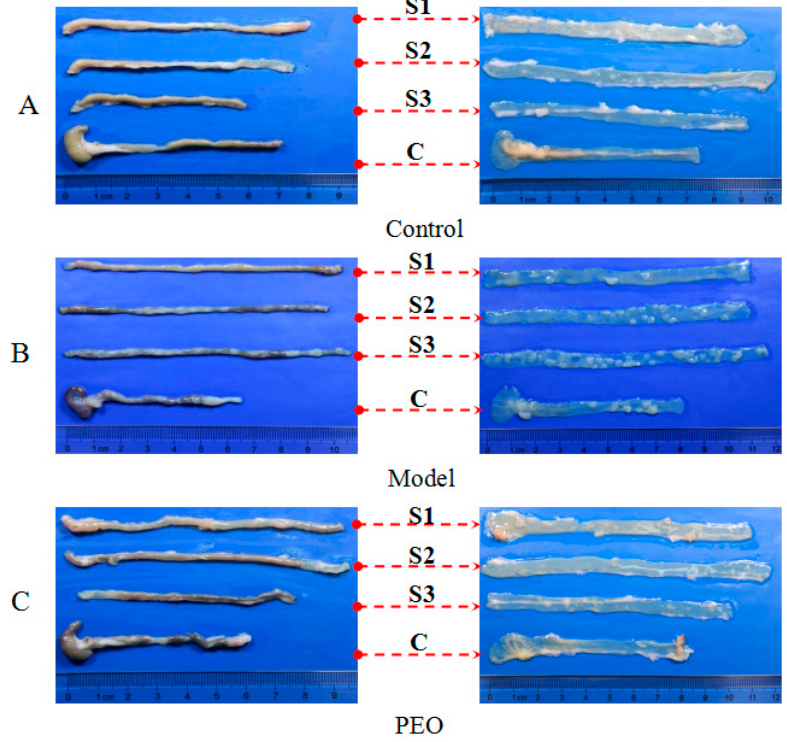
Figure 2. The appearance and morphology of the proximal (S1), middle (S2) and distal (S3) of the small intestine and colon ( C ). ( A ) Control group; ( B ) Model group; ( C ) PEO (0.2% diet) group.